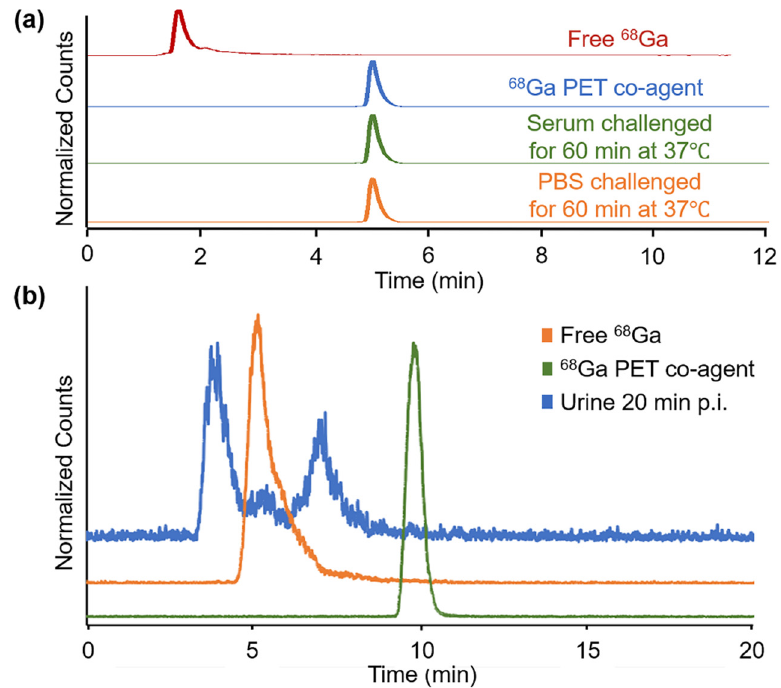
Figure 5. Stability and metabolism of the 68 Ga PET co-agent. ( a ) RadioHPLC of the 68 Ga PET co-agent (blue trace) was incubated in human serum (green trace) and PBS (orange trace) for one hour at 37 ° C and showed complete stability, with no presence of free 68 Ga (red trace). ( b ) RadioHPLC of the 68 Ga PET co-agent from urine collected 20 min post-injection from the mouse imaged with simultaneous PET/MRI, as shown in Figure 4. The results showed the presence of two new species (blue trace) that were different than intact 68 Ga PET co-agent (green trace) or free 68 Ga (orange trace).